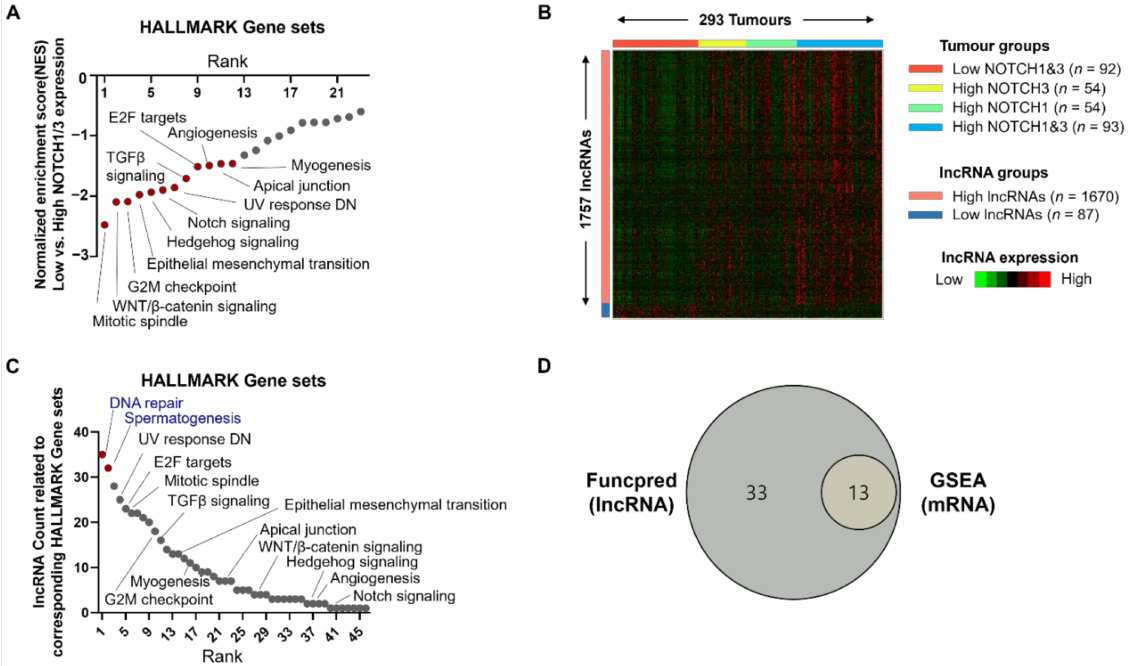
Figure 1. Discovery of Notch-related lncRNAs in HGSC. ( A ) Results of GSEA using Hallmark gene sets in the TCGA HGS-OVCA database (N = 303) to validate our grouping according to NOTCH1/3 expression. “High” indicates a group with high expressions of both NOTCH1 and NOTCH3 ( n = 97). “Low” indicates a group with low expressions of both NOTCH1 and NOTHC3 ( n = 96). The classification into high and low was based on median TPM values. High NOTCH1 with low NOTCH3 ( n = 55) and high NOTCH3 with low NOTCH1 ( n = 55) were excluded from this analysis. Red coloured dots indicated statistically significant p -value (<0.05) and FDR q-value (<0.025). ( B ) Identification of differentially expressed lncRNAs using TANRIC database ( n = 293). Ten of the TCGA HGS-OVCA cases ( n = 303) did not show lncRNA expression. Heatmap showing representa- tive lncRNAs ( n = 1757) according to NOTCH1/3 expression status. Based on the expression status of NOTCH1/3, TCGA HGS-OVCA dataset was divided into four groups: I ( n = 92), low expression of both NOTCH1 and 3; II ( n = 54), high expression of NOTCH3 and low expression of NOTCH1; III ( n = 54), high expression of NOTCH1 and low expression of NOTCH3; and IV ( n = 93), high expres- sion of both NOTCH1 and 3. ( C ) Potential function of Notch-related lncRNAs using FuncPred. Red coloured dots indicate unique gene sets highly ranked in this analysis but not in GSEA depicted in ( A ). ( D ) Venn diagram presenting the logical relation between FuncPred data with lncRNAs and GSEA data with mRNAs. Abbreviations: NOTCH1/3, Notch receptor 1 and 3; TCGA, The Cancer Genome Atlas; HGS-OVCA, high-grade serous ovarian cancer; lncRNA, long non-coding RNA; GSEA, gene set enrichment analysis; FuncPred, in silico prediction of gene function for protein-coding and lncRNA human